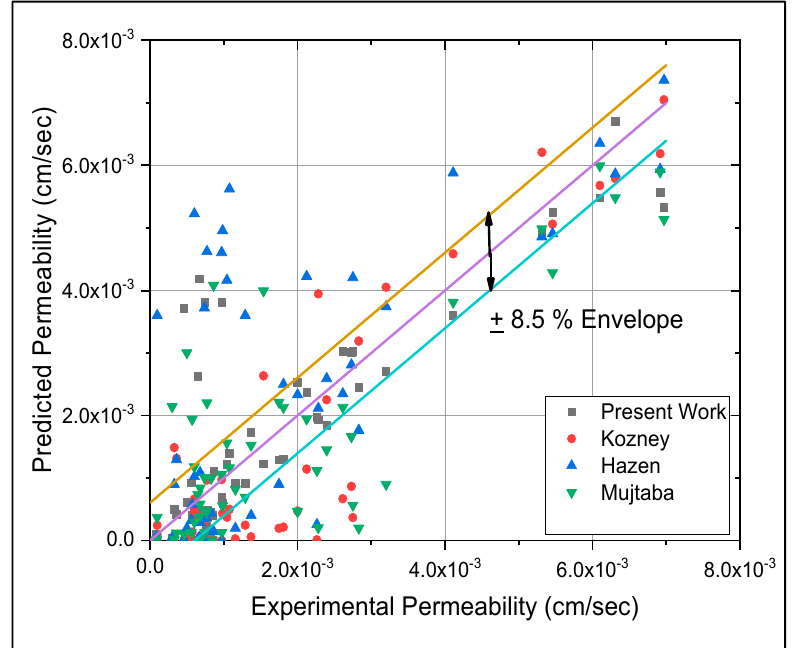
Figure 10. Comparison of equations. Table 2. Field permeability data for validation.